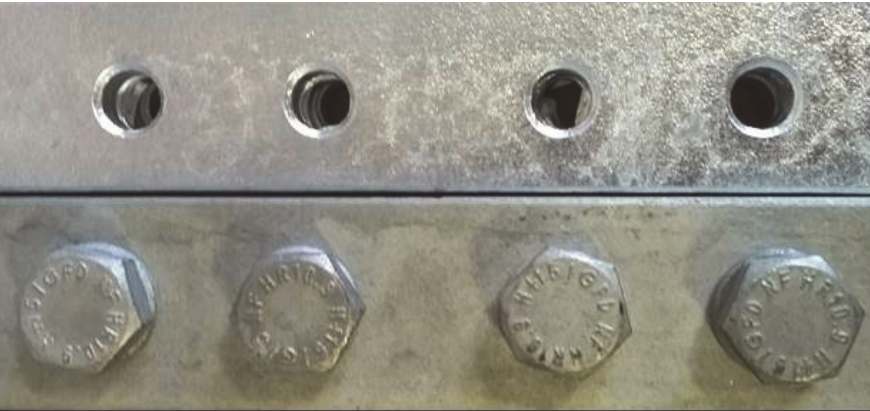
Figure 3: Comparison between specimens before and after sweep